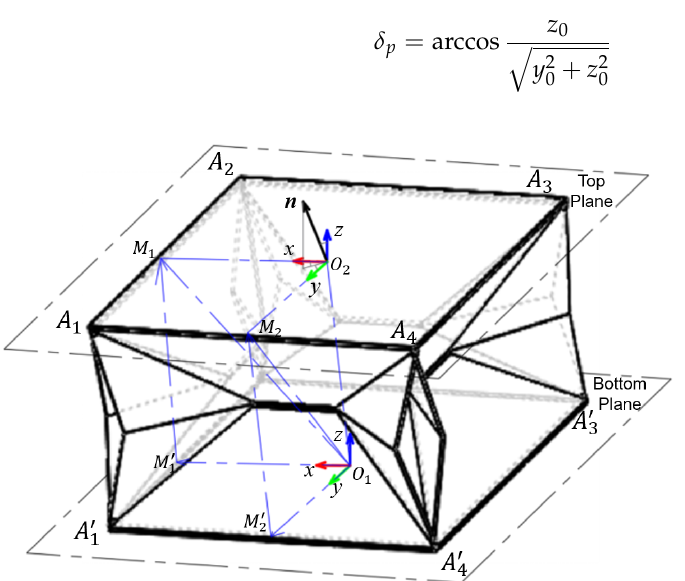
Figure 5. Origami kinematic model: we model our system as two rigid plates connected with four legs. When this foldable structure generates the pitch and roll motion, the top surface will form a certain angle relative to the bottom